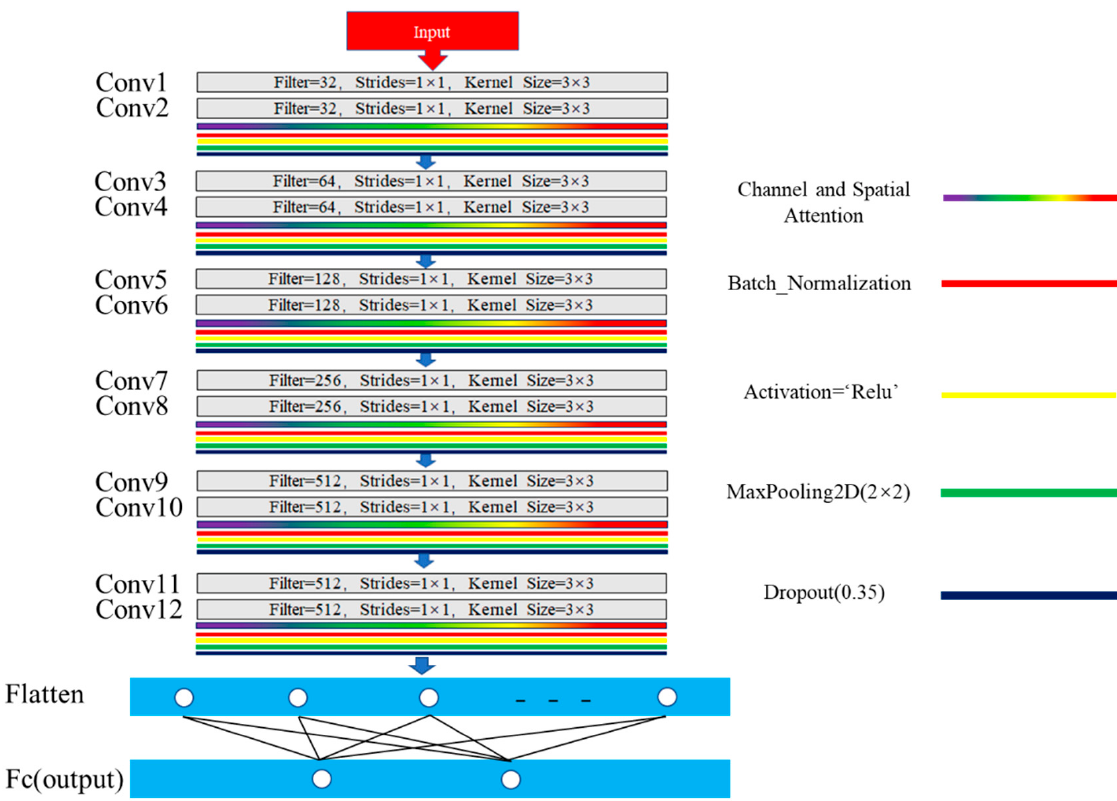
Figure 4. Modified network structure based on VGG13.